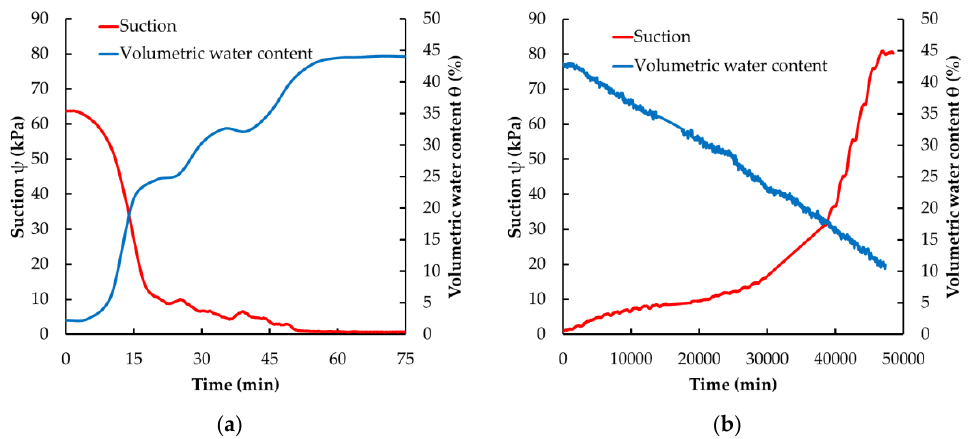
Figure 4. ( a ) Wetting phase monitoring. ( b ) Drying phase monitoring.